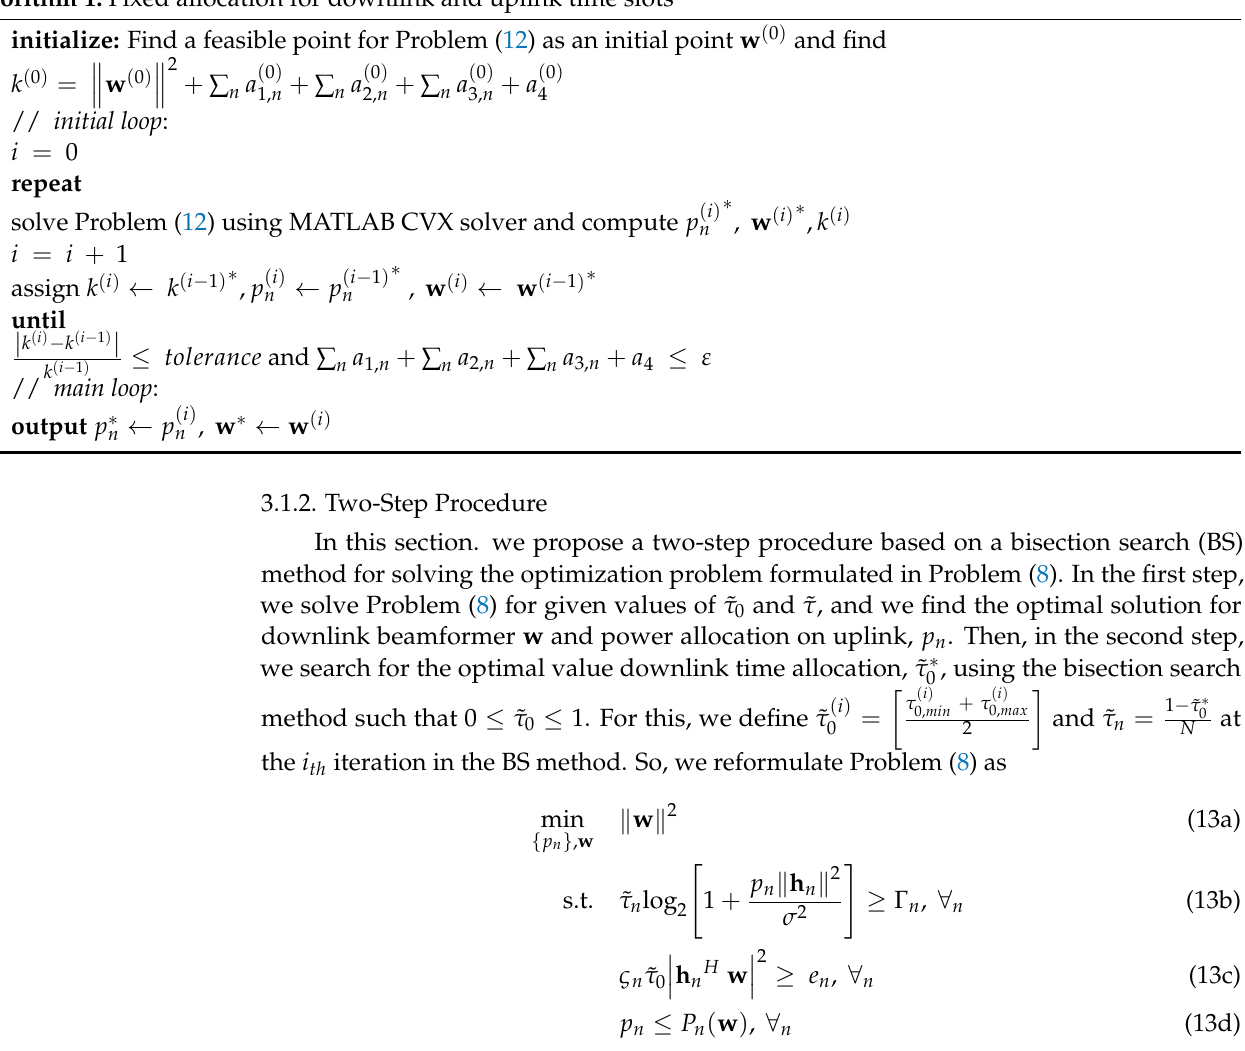
Algorithm 1: Fixed allocation for downlink and uplink time